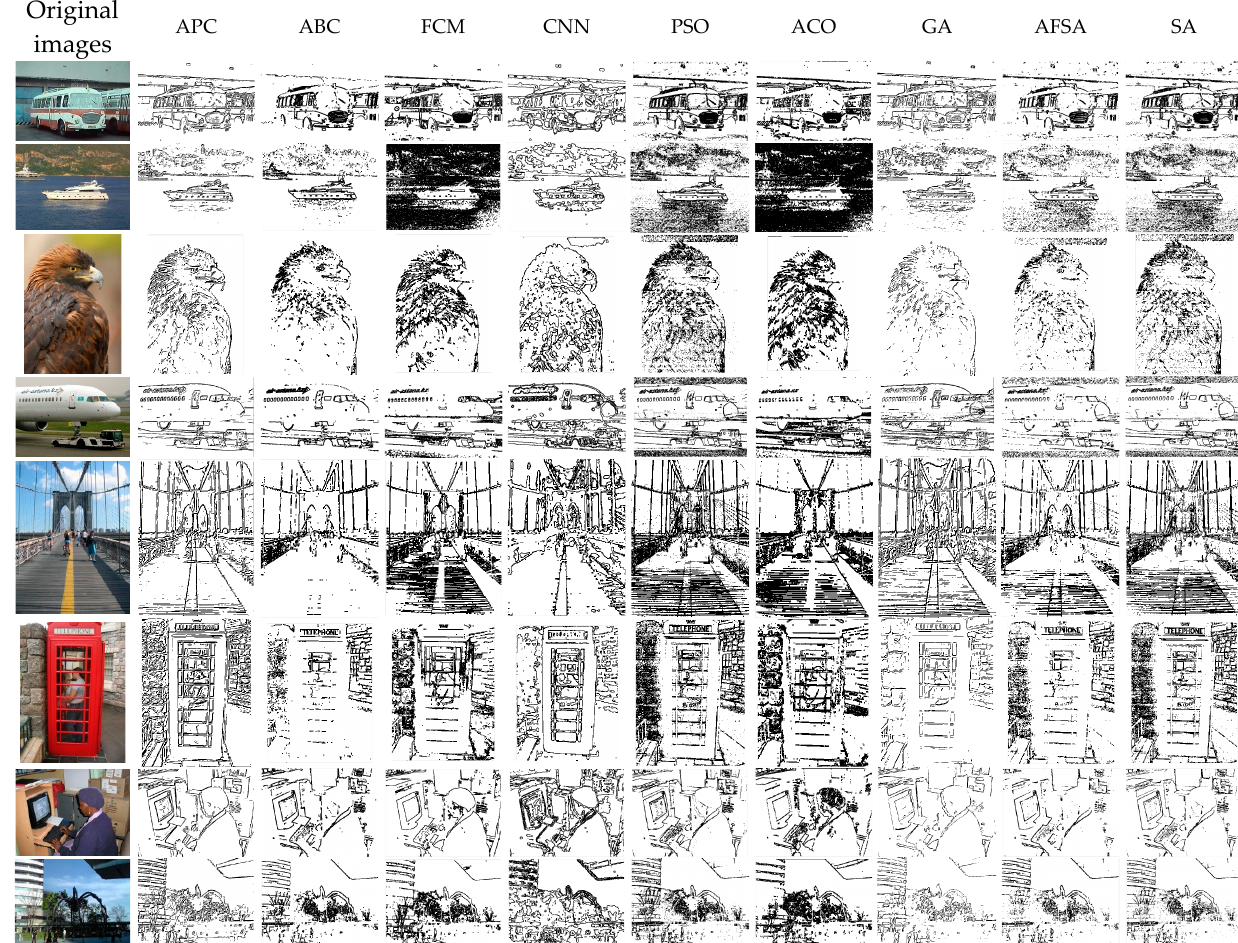
Figure 5. Algorithm comparison using the Pascal VOC 2012 dataset; ABC [5,41]; FCM [9,14,31,32]; CNN [14–17,34–37]; PSO [18,40]; ACO [19,21]; GA [22,42]; AFSA [23]; SA [26].